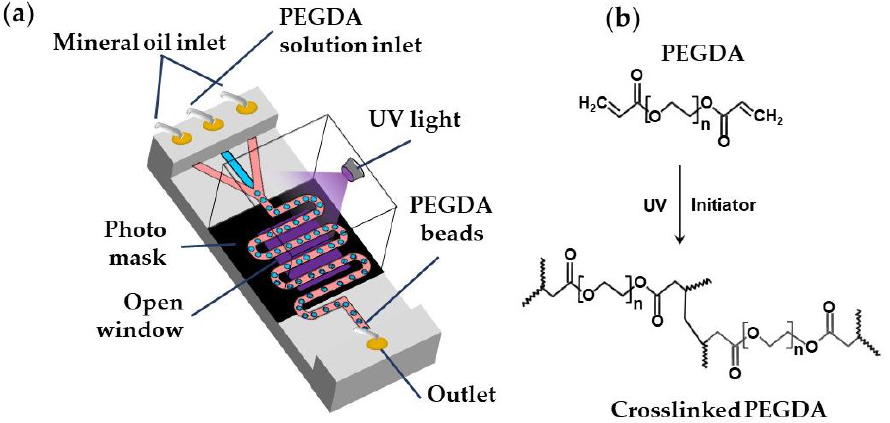
Figure 24. ( a ) Formation of poly(ethylene glycol diacrylate) (PEGDA) beads by the UV light-induced